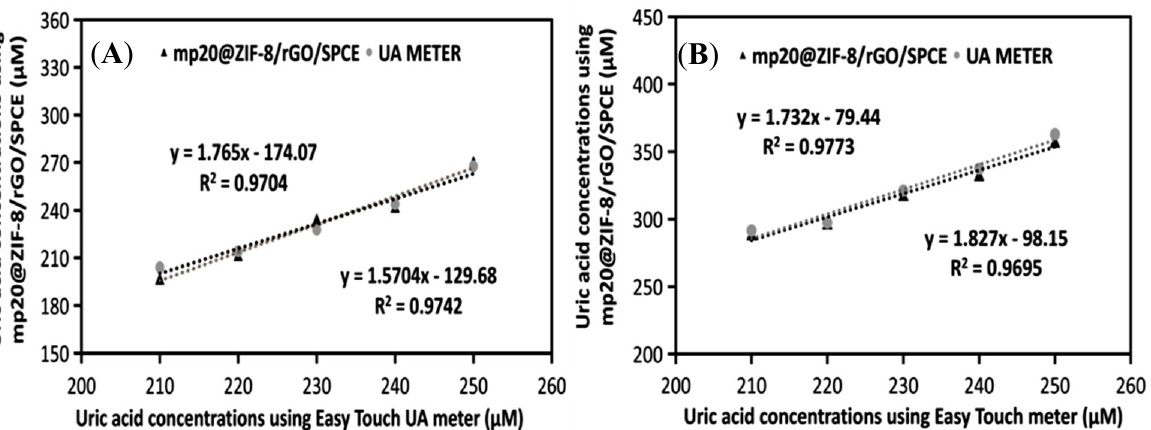
Figure 8. Data validation of uric acid by biosensor mp20@ZIF-8/rGO/SPCE and UA meter in physiological fluids; ( A ) human serum and ( B ) urine.